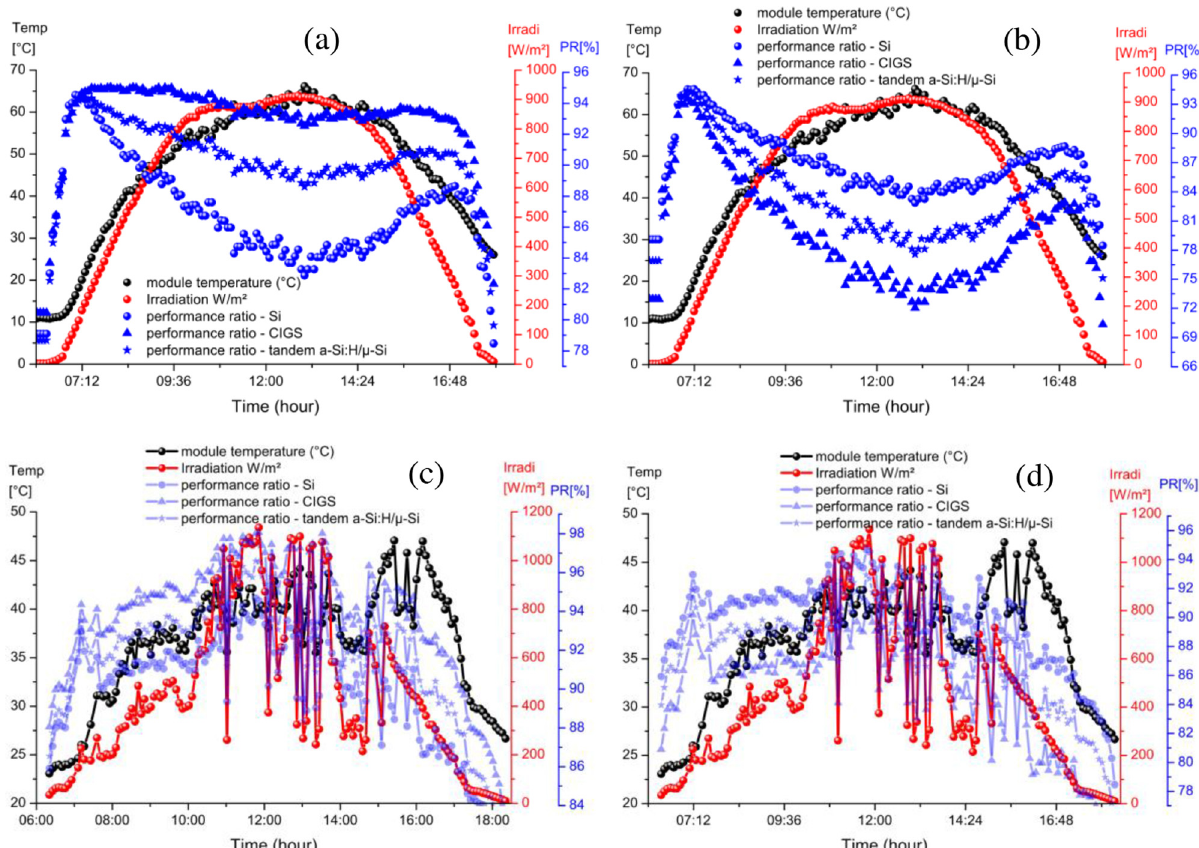
Fig. 5. Daily evolution of the PR of different photovoltaic modules with: main recombinant centers in volume for a clear day (a) and cloudy day (c), main recombinant centers at the interface for a clear day (b) and cloudy day